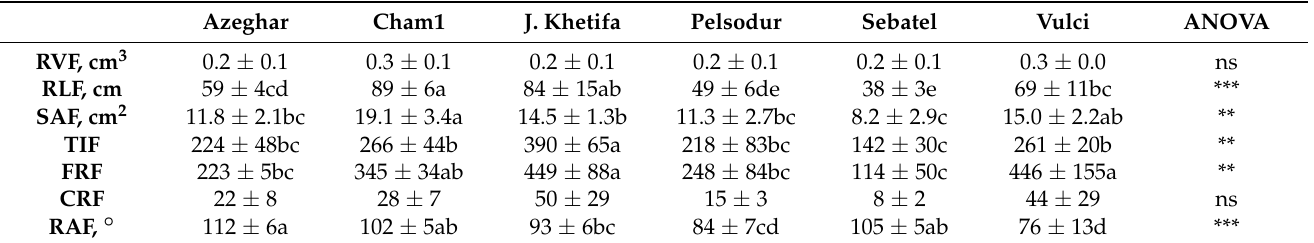
Table 4. Root characteristics of plants collected from field at a depth of the first 5 cm below ground. Azeghar Cham1 Values are means ± standard deviations ( n = 3). Means with same letter in the line are not significantly different between genotypes ( p < 0.05) (LSD test). RVF—root volume in the first 5 cm below the ground of plants from field; RLF—sum of all root lengths in the first 5 cm below the ground of plants from field of plants from field; SAF—root surface area in the first 5 cm below the ground of plants from field of plants from field; TIF—number of tips in the first 5 cm below the ground of plants from field of plants from field; FRF—number of forks in the first 5 cm below the ground of plants from field of plants from field; CRF—number of crossings in the first 5 cm below the ground of plants from field of plants from field; RAF—root angle of plants grown in field. ns—Not significant; **, and *** indicate significance at p < 0.01 and p < 0.001 levels, respectively. The comparison between genotype root angles, measured using ImageJ software